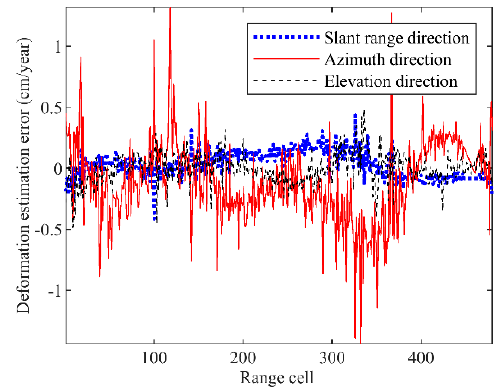
Figure 10. The estimation errors of 3-D deformation velocities for the scatterers located in the slice.